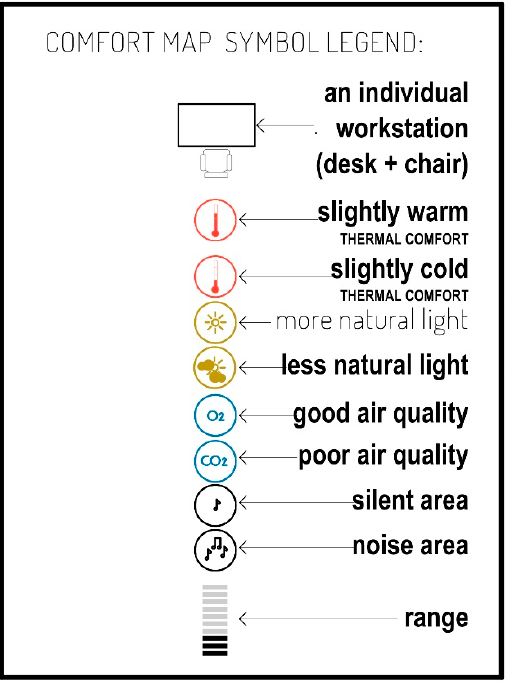
Figure A1. Reference Values for PMV and PPD Parameters